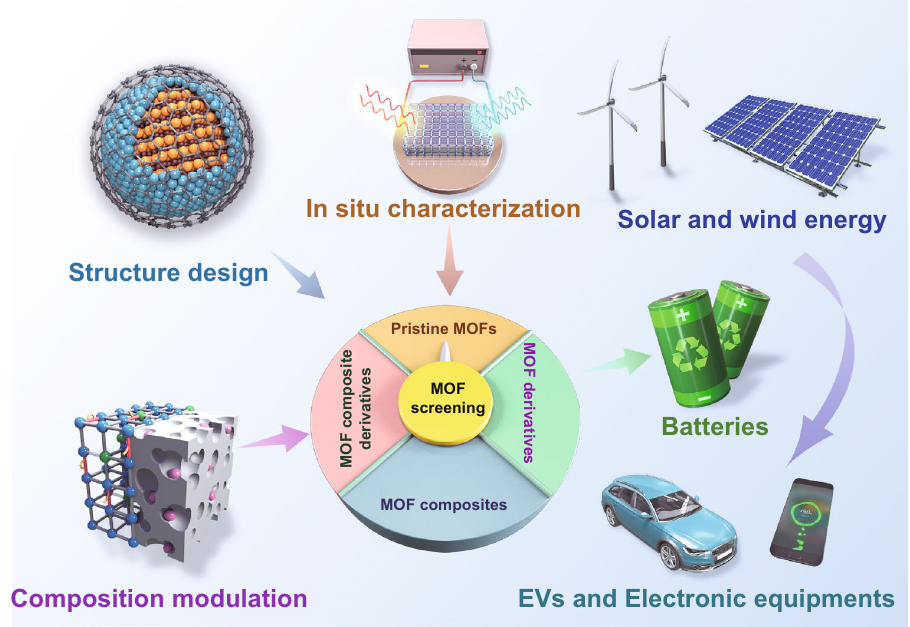
Fig. 7 Challenges of MOF-based materials for batteries, mainly including composition modulation and structure design, advanced in situ char- acterizations, rational MOFs screening, and practical